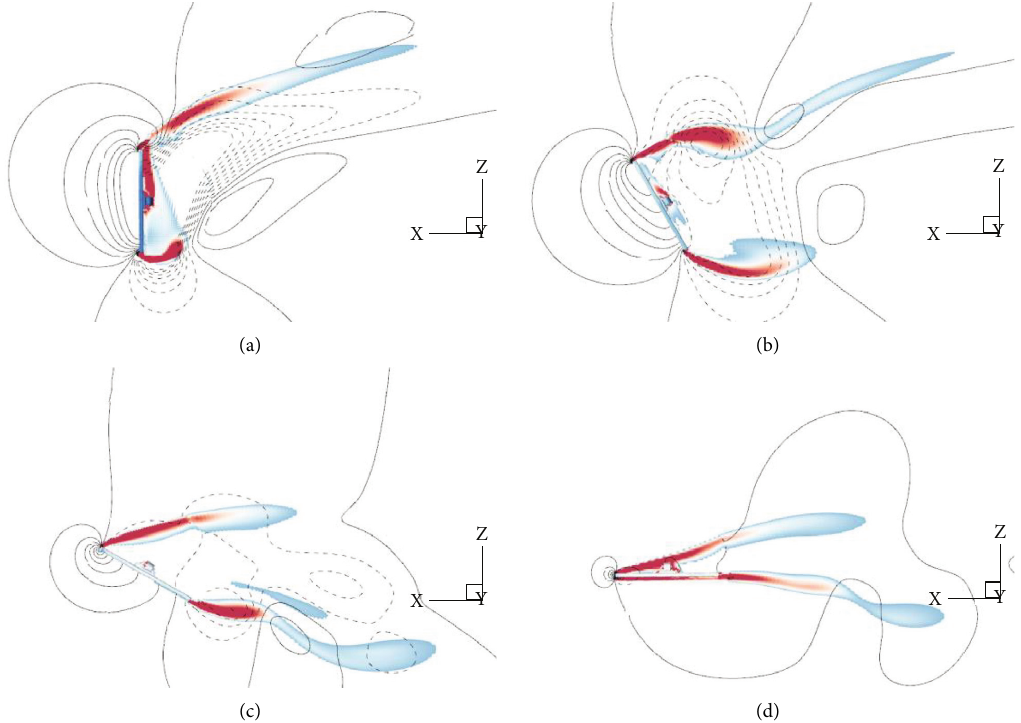
Figure 13: Vorticity nephogram and pressure isosurface nephogram (black solid line represents positive pressure value, black dotted line represents negative pressure value, and color cloud images represent vorticity), (a) β � 0 ° , (b) β � 30 ° , (c) β � 60 ° , and (d) β � 90 ° .